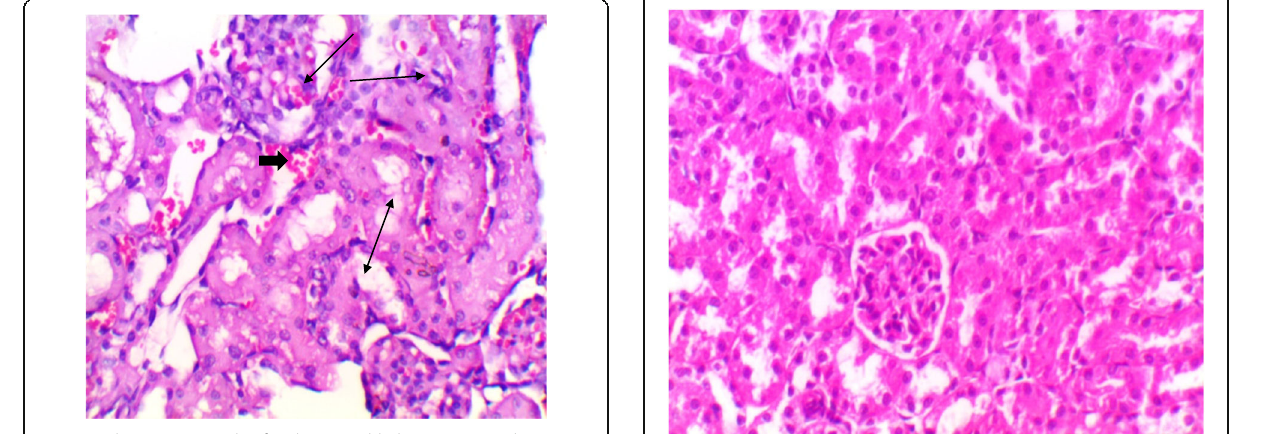
Fig. 17 Photomicrograph of CCl4-treated kidney sections showing congestion (thick arrow), vacuolation (2head arrow) and, inflammatory changes (arrow) (H&E; × 400)